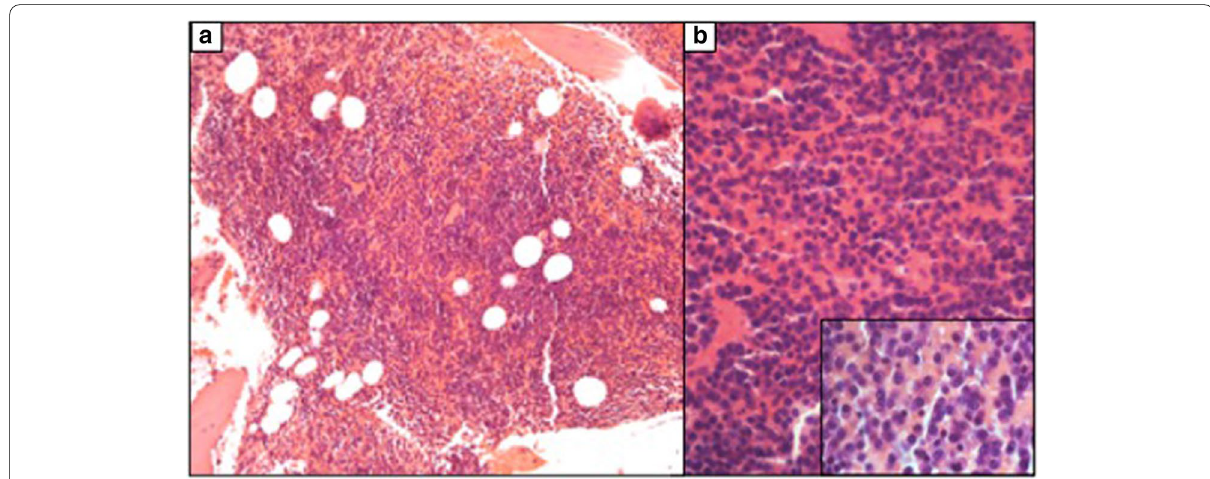
Fig. 1 a Bone marrow with diffuse Interstitial infiltration of mature and immature plasma cells (H&E 4x); b Plasmatic cell detail, round eccentric nuclei with cart‑wheel chromatin and variable nucleoli (in set), with abundant basophilic cytoplasm (H&E 20x,